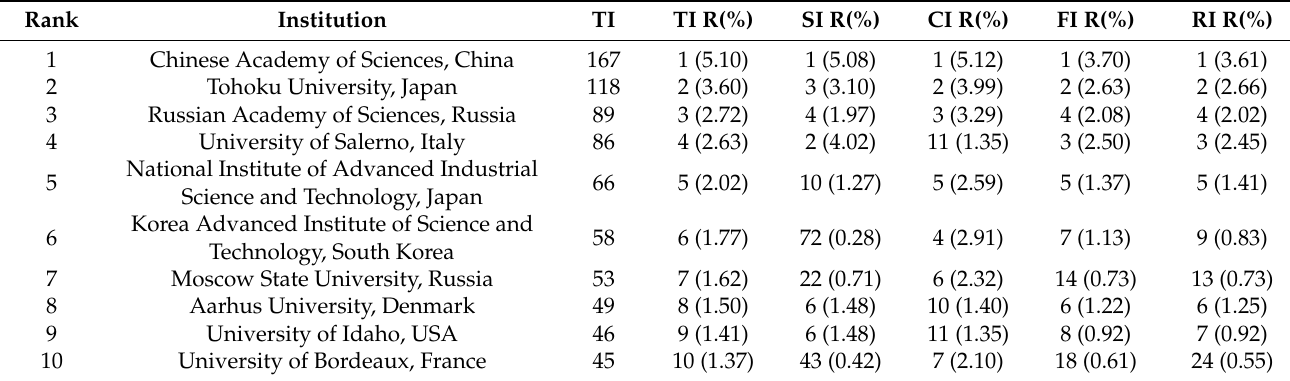
Table 3. Top ten institutions that published papers from 1998 to